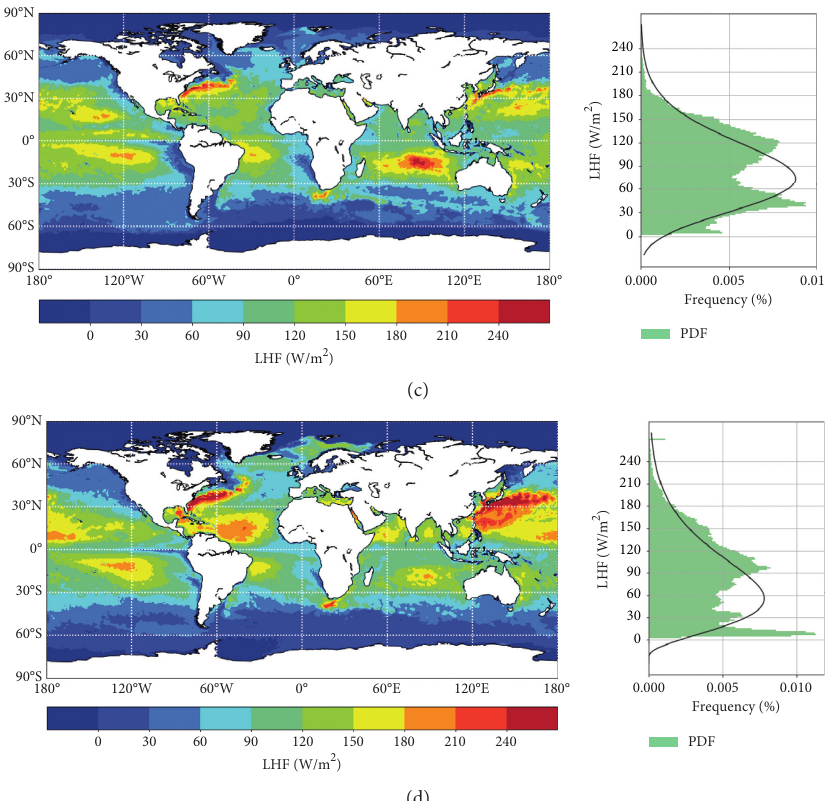
Figure 5: Seasonal patterns of LHF: (a) MAM (March, April, and May); (b) JJA (June, July, and August); (c) SON (September, October, and November); (d) DJF (December, January, and